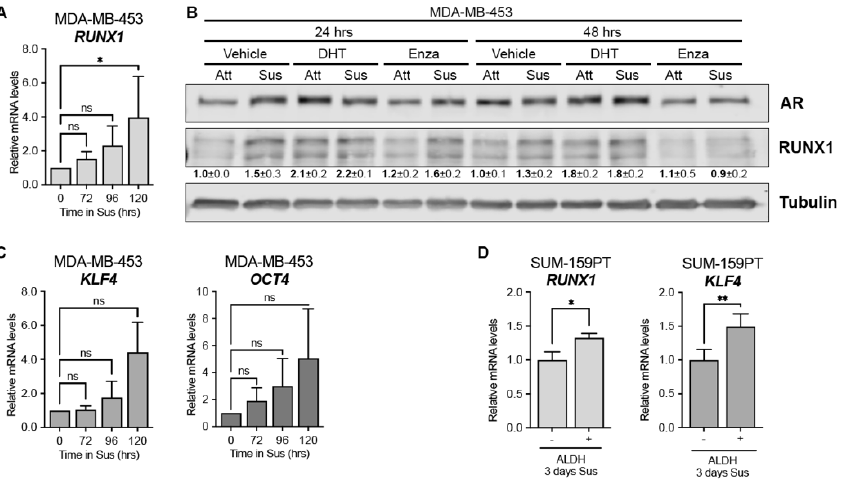
Figure 2. RUNX1 is upregulated in CSC-like subpopulations. mRNA levels of RUNX1 ( A ), KLF4, and OCT4 ( C ) after 72, 96 and 120 h in forced suspension (Sus) were determined by qPCR. GAPDH was used as a housekeeping control. ( B ) AR and RUNX1 Western blot of MDA-MB-453 cells culture in at- tached (Att) or forced-suspension conditions (Sus) and treated with either vehicle (DMSO + ethanol), DHT (10 nM) or Enza (20 µ M) for 24 and 48 h. Tubulin was used as a housekeeping control. ( D ) SUM- 159PT were cultured in forced-suspension conditions for 3 days and then sorted using ALDEFLUOR assay. mRNA was prepared from ALDH − and ALDH + subpopulations and RUNX1 and KLF4 levels were evaluated by qPCR. GAPDH was used as a housekeeping control. One-way ANOVA followed by Tukey multiple comparison ( A , C ) or Student t -test ( D ) were performed from three independent experiments. * p < 0.05, ** p < 0.01 and ns = not significant. One representative experiment of three is shown in ( C ), mean ± SEM is